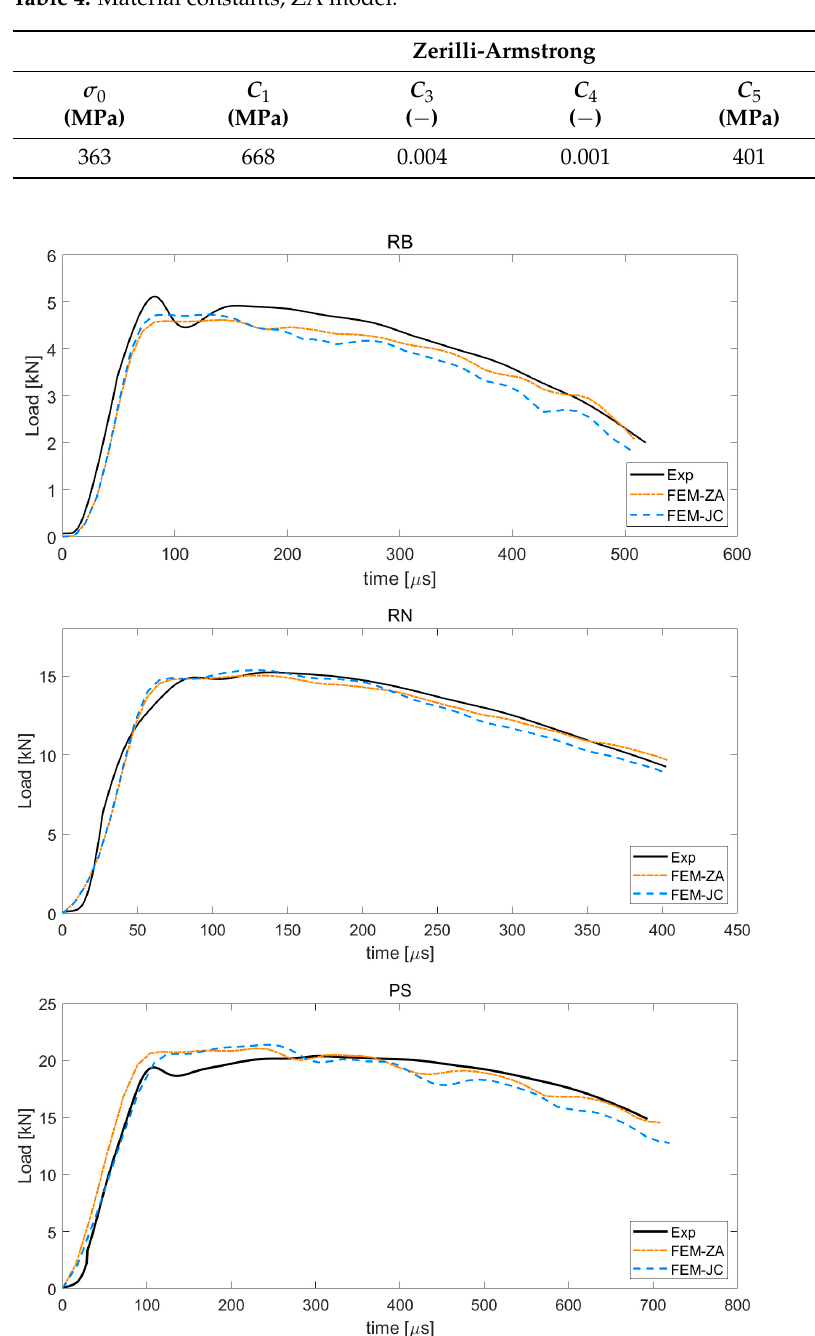
Figure 8. Comparison between experimental and numerical load–displacement curves for RB, RN and PS, for both JC and ZA plasticity models.